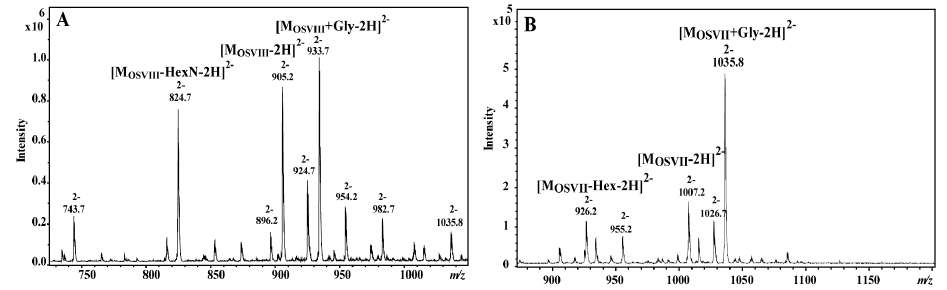
Figure 2. ESI (electrospray ionization) mass spectra of the core oligosaccharide fractions ( A ) OSVIII and ( B ) OSVII of E. tarda EIB 202.